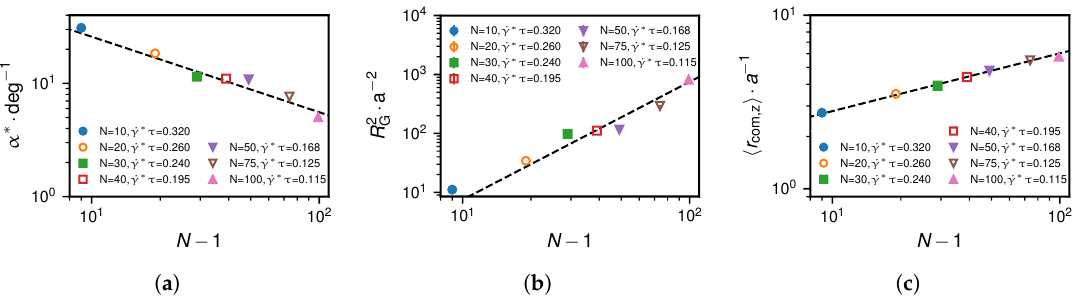
Figure 12. Grafted scenario at the critical shear rate ˙ γ ∗ : Subfigure ( a ) depicts the simulation results for the angle α , subfigure ( b ) for the mean-square radius of gyration R 2 (cid:104) r com,z (cid:105) depending on the monomer number, N − 1. The deduced heuristic scaling relations which are indicated by dashed lines are α ∼ ( N − 1 ) − 2/3 , R 2